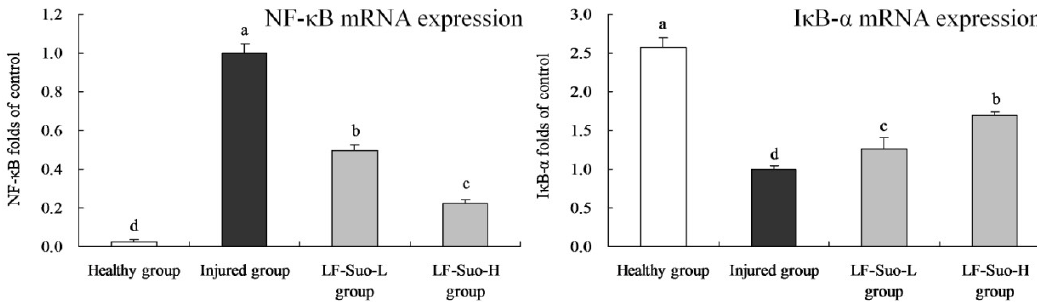
Figure 5. NF ‐κ B, I κ B ‐α mRNA expression of studied mice. Fold ‐ ratio: gene expression/GAPDH × injured group numerical value (injured group fold ratio: 1). a–d Mean values with different letters in the same column are significantly different ( p < 0.05) according to Duncan’s multiple ‐ range test. LF ‐ Suo ‐ L, Lactobacillus fermentum Suo (0.5 × 10 9 CFU/kg b.w.); LF ‐ Suo ‐ H, Lactobacillus fermentum Suo (1.0 × 10 9 CFU/kg b.w.).